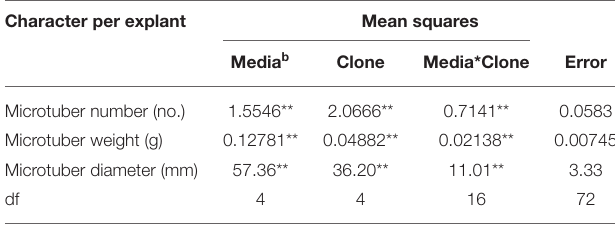
TABLE 1 | Analysis of variance for in vitro tuberization of five selected potato clones a in various microtuberization media.